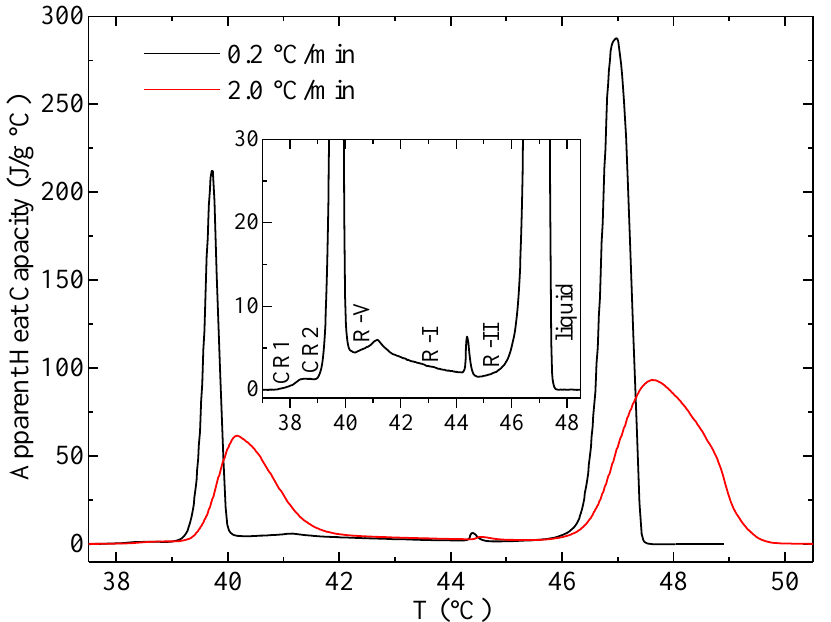
Figure 2. Differential scanning calorimetry (DSC) heating curves, at the indicated scanning rates, for the C 23 H 48 sample.